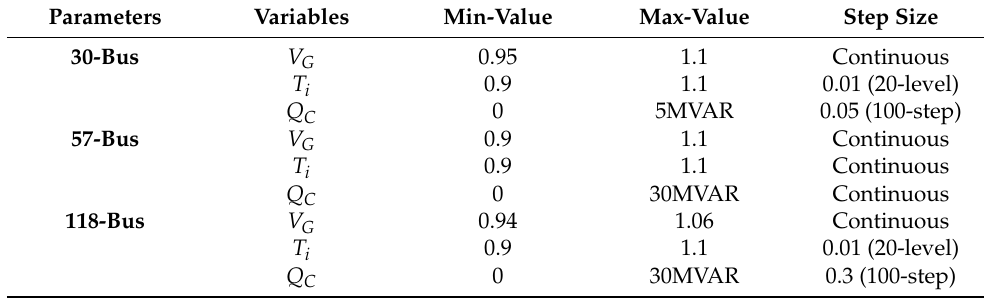
Table 5. Control variable limits for various IEEE cases (pu).